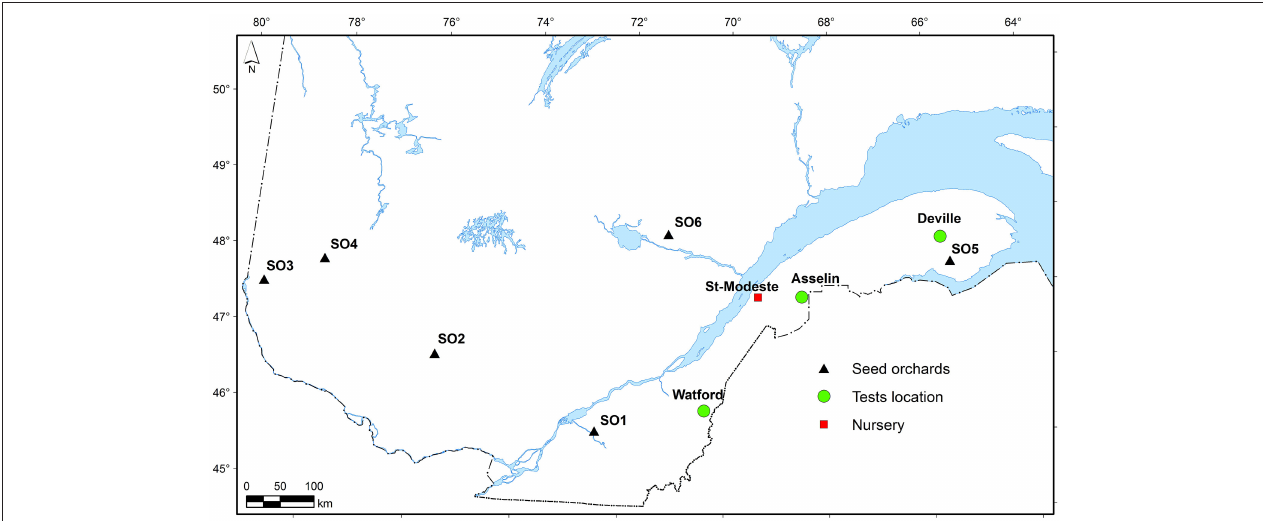
FIGURE 1 | Location of the planting sites and the six seed sources (SO) used in the current study.